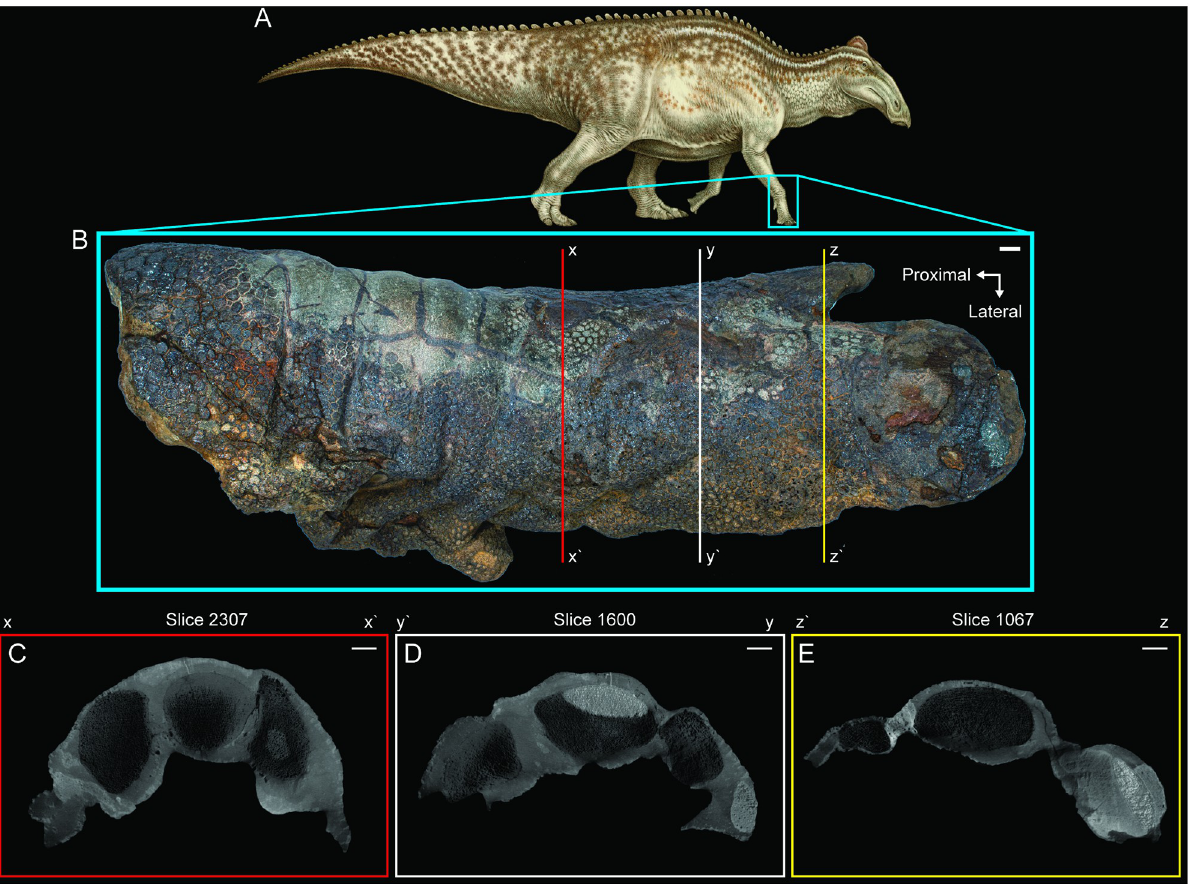
Fig 4. Cross sectional views through the right manus of NDGS 2000. (A) NDGS 2000 reconstruction in right lateral view. (B) Right manus in dorsal view indicating the positions of the three cross sectional views. (C) CT image along line x to x’. (D) CT image along line y to y’. (E) CT image along line z to z’. In (C), (D), and (E), slice numbers from the original CT data are provided above each image. Paleoart in (A) by Natee Puttapipat. Scale bars equal 1